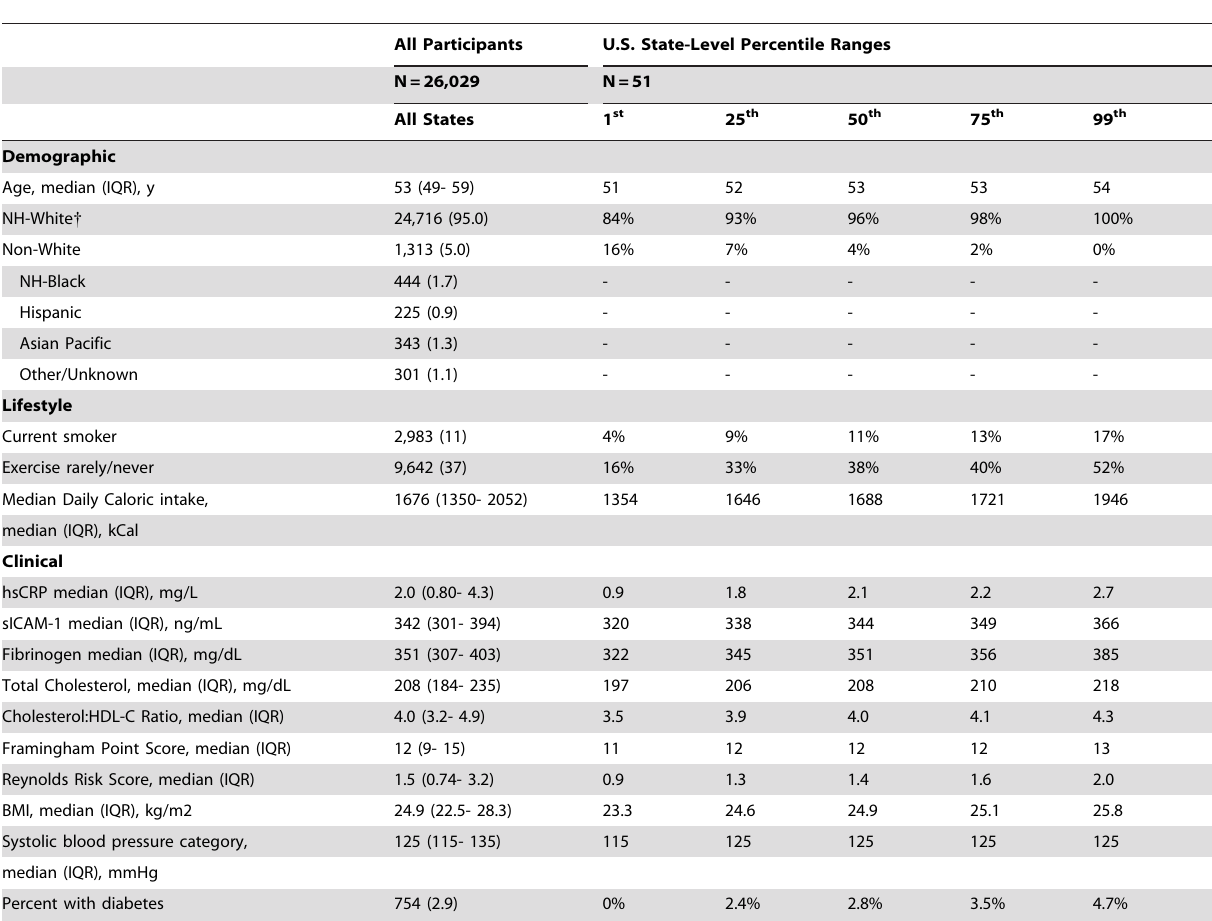
Table 1. Selected Demographic, Lifestyle, and Clinical Characteristics of Women’s Health Study Participants: With State-Level